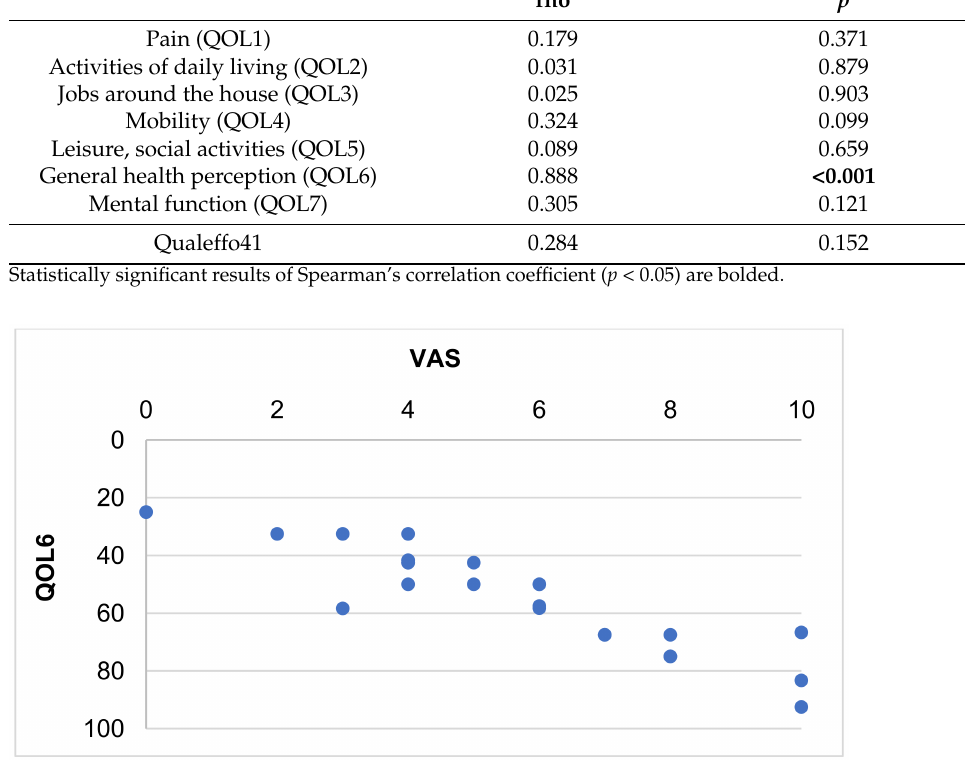
Figure 2. Scatter plot of pain severity (VAS) and general health perception (QOL6) in men with